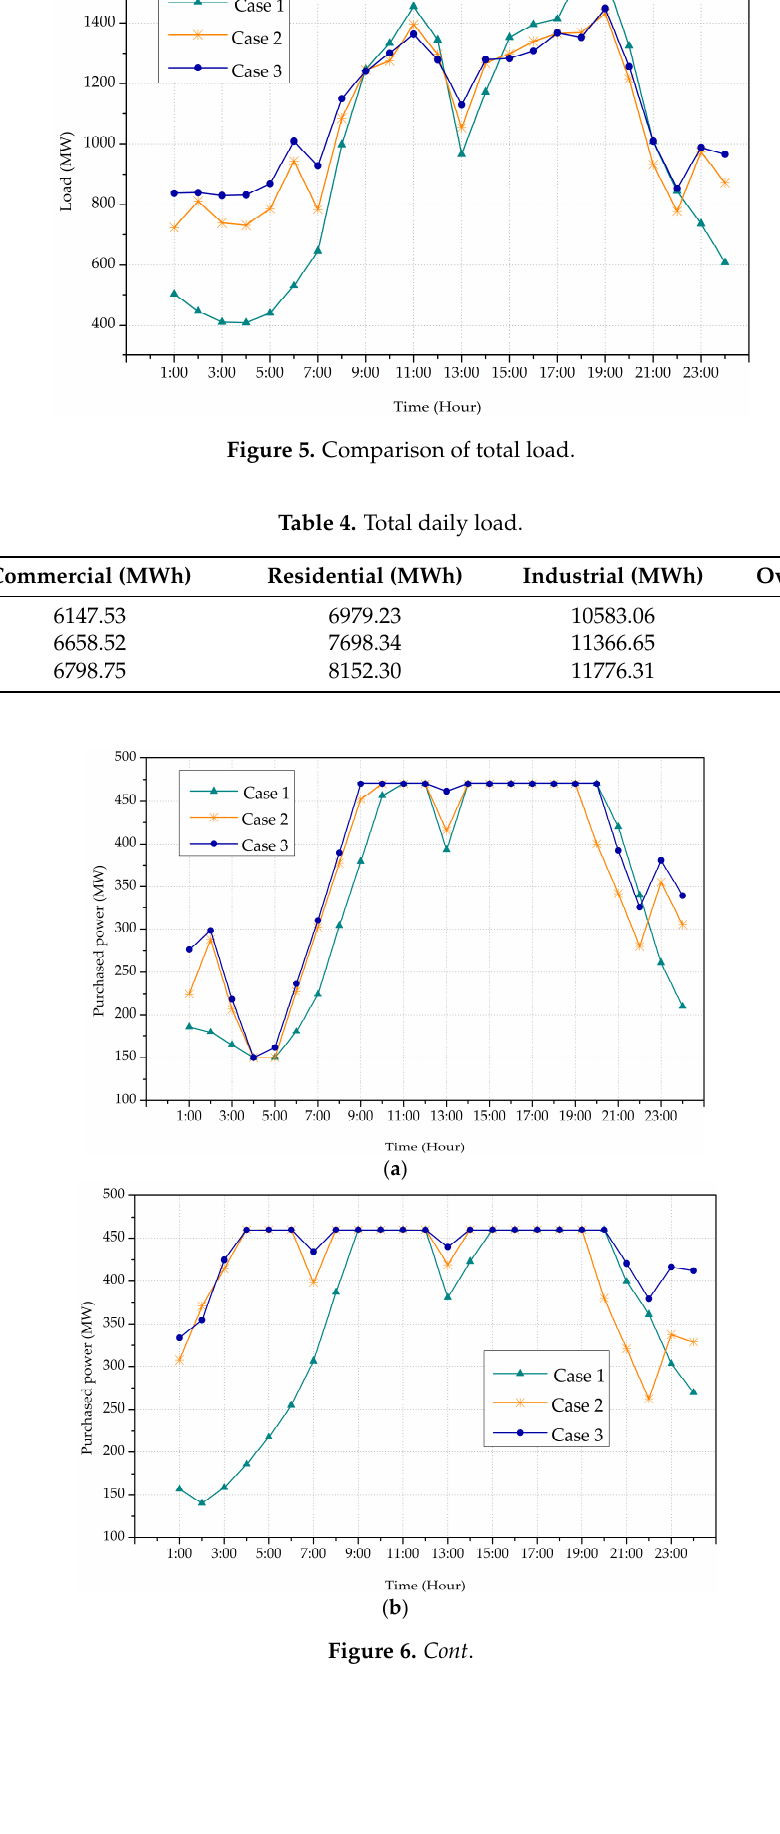
Figure 4. ( a ) Load profiles of commercial customers; ( b ) Load profiles of residential customers; ( c ) Load profiles of industrial customers.